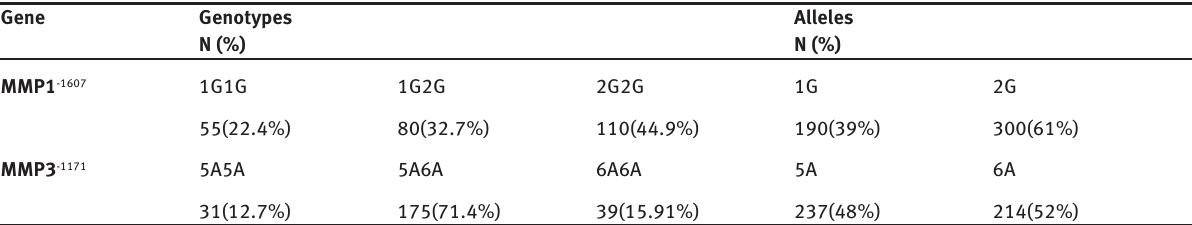
Table 2: Genotypic frequency of MMP1 and MMP3 in the general population. Gene Genotypes